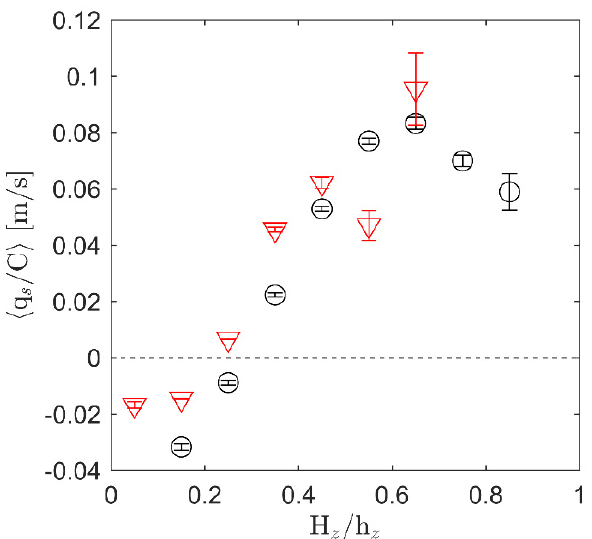
Figure 20. Near-bed (z < 10 cm) flux efficiency ( F = < q s >/< c >) plotted against relative zero-crossing wave height for two beaches dominated by plunging (black circles) and spilling (red triangles) breakers. Positive F is onshore directed. The vertical bars denote the standard error on the mean values. Modified from Christensen et al. [74].